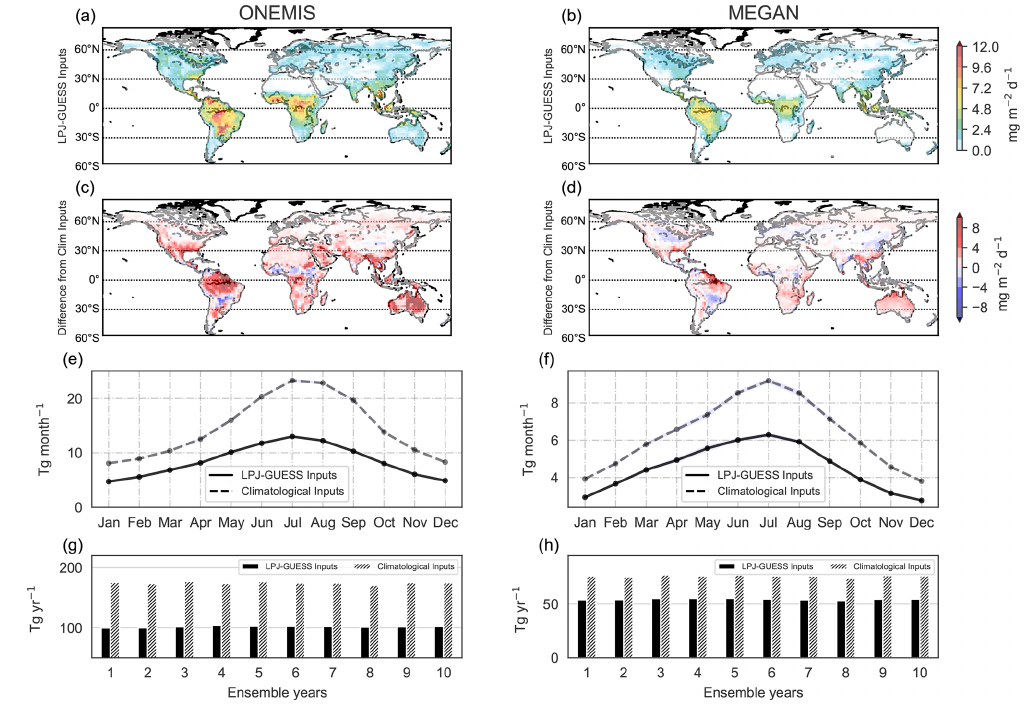
Figure 9. Same as Fig. 8 but for monoterpenes.